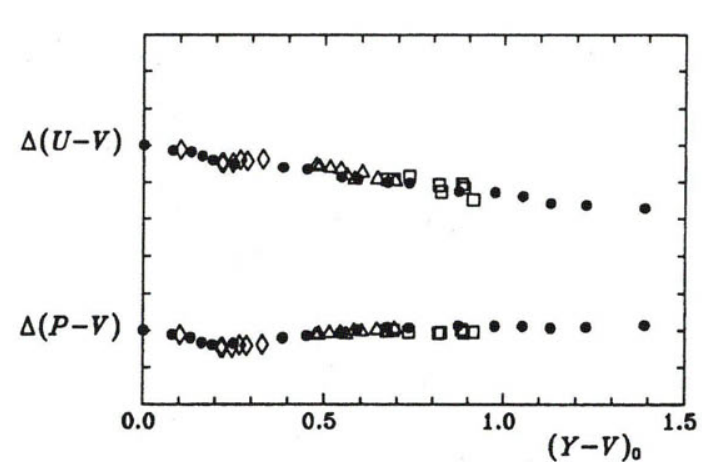
Fig. 3. Differences of synthetic color indices (standard minus CCD) plotted against Y-V. Dots are for main sequence stars, triangles are for subdwarfs, squares are for metal-deficient giants and diamonds are for blue horizontal branch stars. On both axes the ticks at each 0.1 mag are